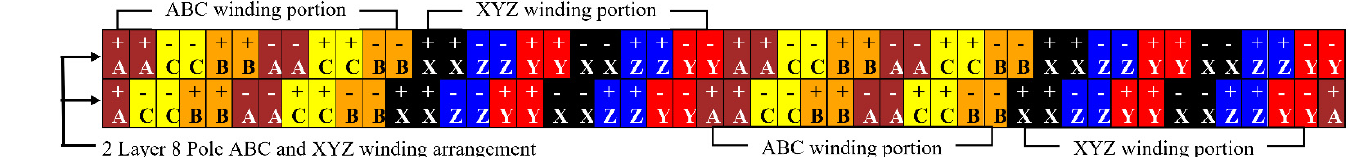
Figure 6. 2-layer ABC and XYZ winding configuration in over 360-mechanical degrees presented in [15].